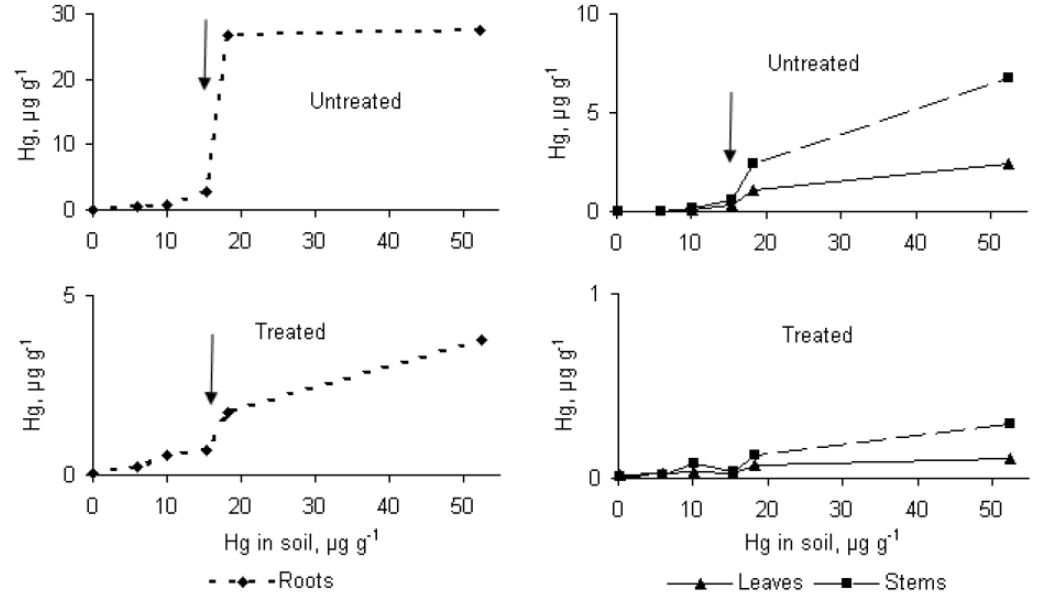
Fig. 3 Hg content in the oats Avena sativa L. tissues, untreated and treated variants.